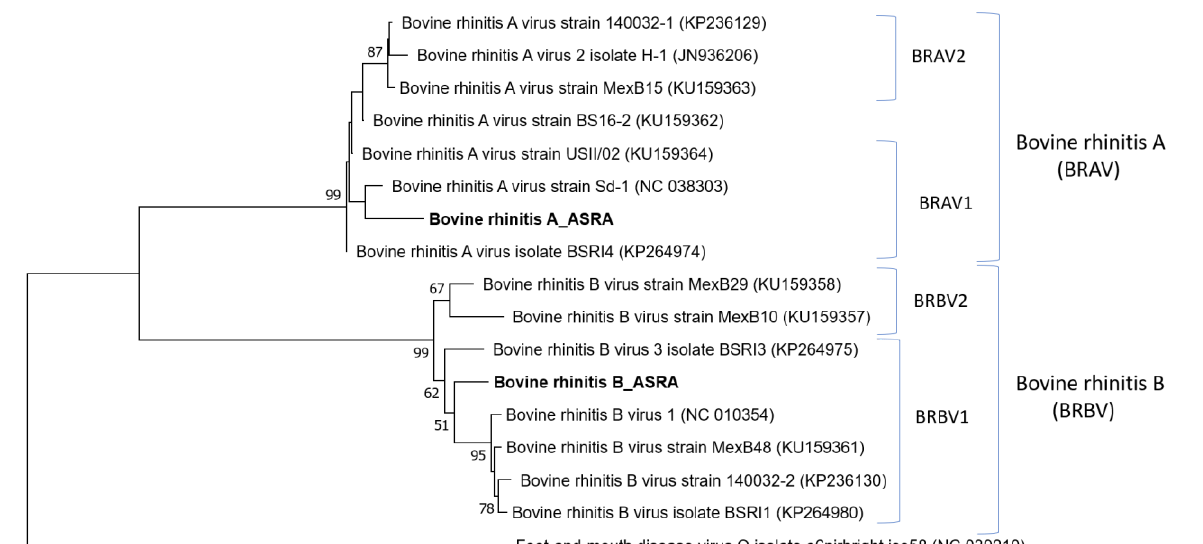
Figure 5. Phylogenetic tree of Aphthovirus based on the polyprotein gene. The phylogenetic tree was constructed using the maximum likelihood method based on the Kimura 2-parameter model [27]. Bootstrapping of 1000 replicates was performed.